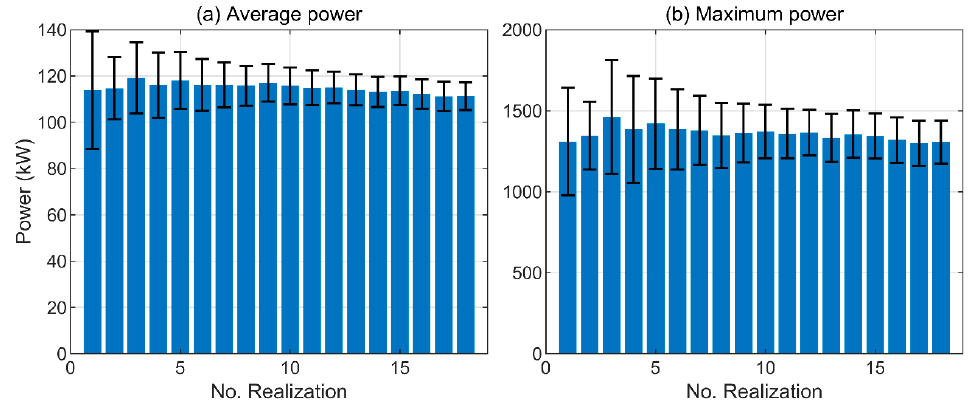
Figure 8. Energy period values computed from FUNWAVE post-processed spectra for the case of ( a ) warm weather and ( b ) cold weather months, compared to hindcast benchmarks. warm weather and ( b ) cold weather months, compared to hindcast benchmarks.